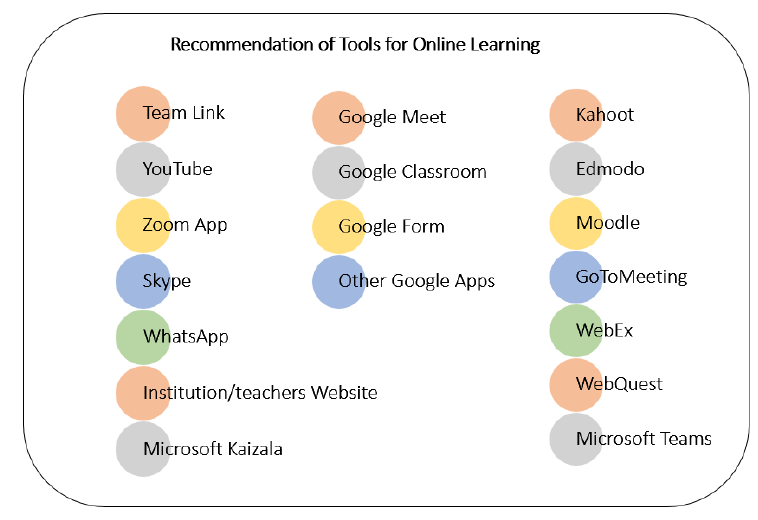
Fig. 7. Recommendation of tools for online